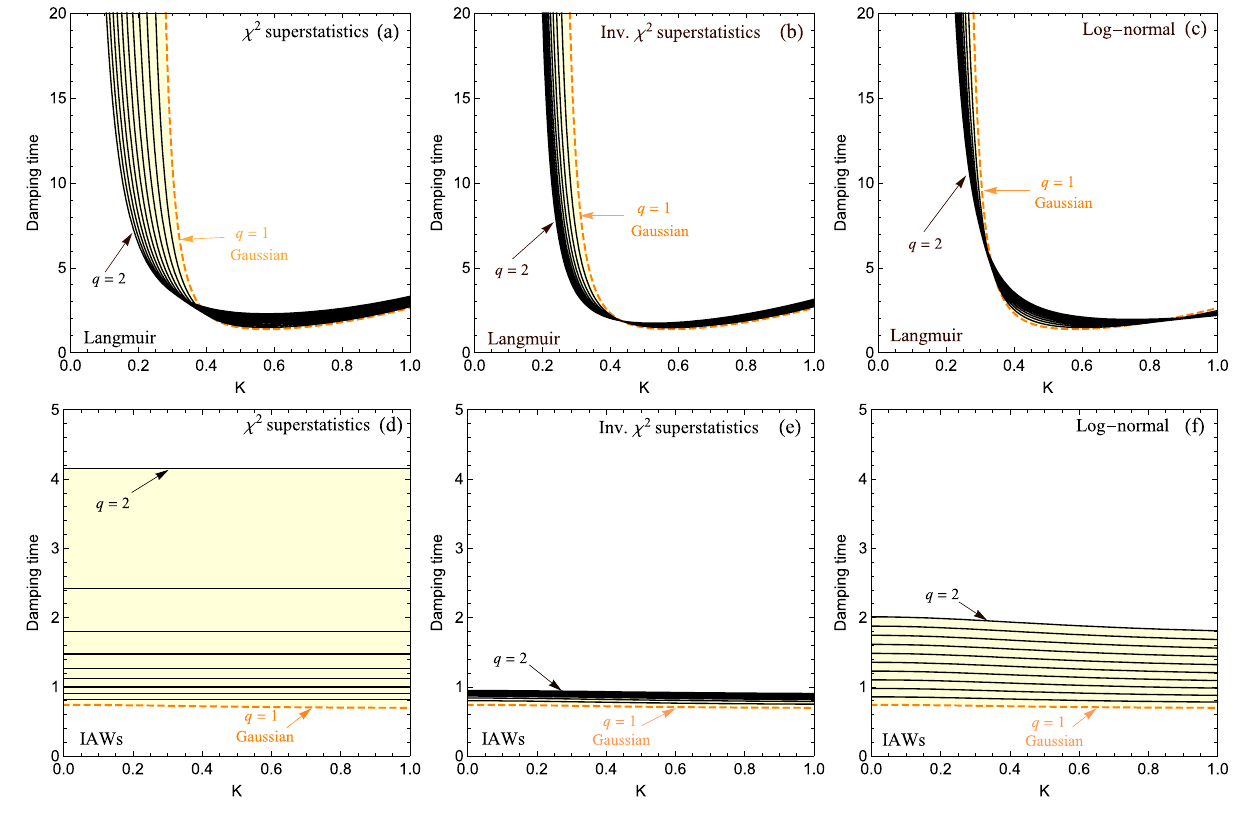
2 2 ( a , d ), inverse- χ